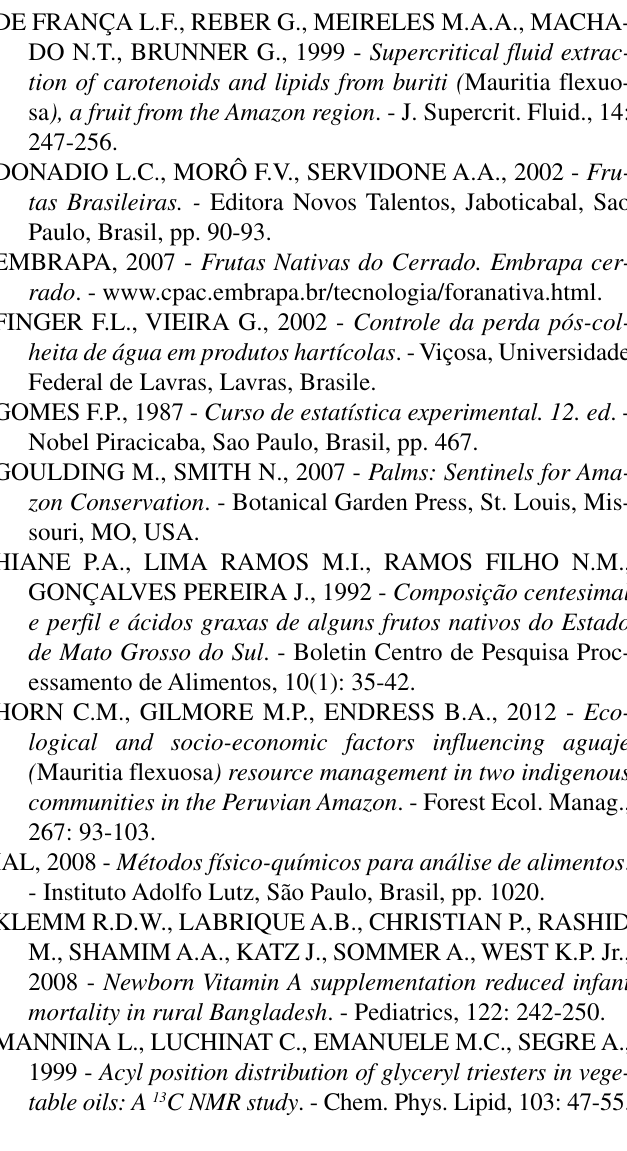
table oils: A 13 C NMR study . - Chem. Phys. Lipid, 103: